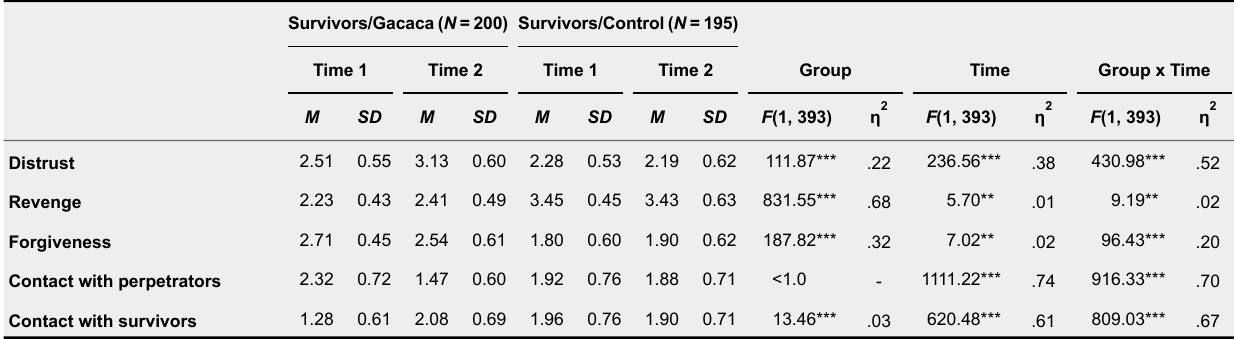
Comparison of survivors who took part in Gacaca and survivors who did not yet participate (control group) for measurements taken before (Time 1) and after (Time 2)